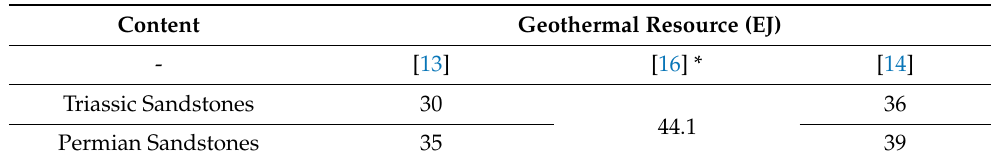
Table 3. Geothermal resource estimates from literature: 1 EJ = 1 × 10 18 J. Data collated from Downing and Gray [13], Jackson [16], Rollin et al. [14]. Content Triassic